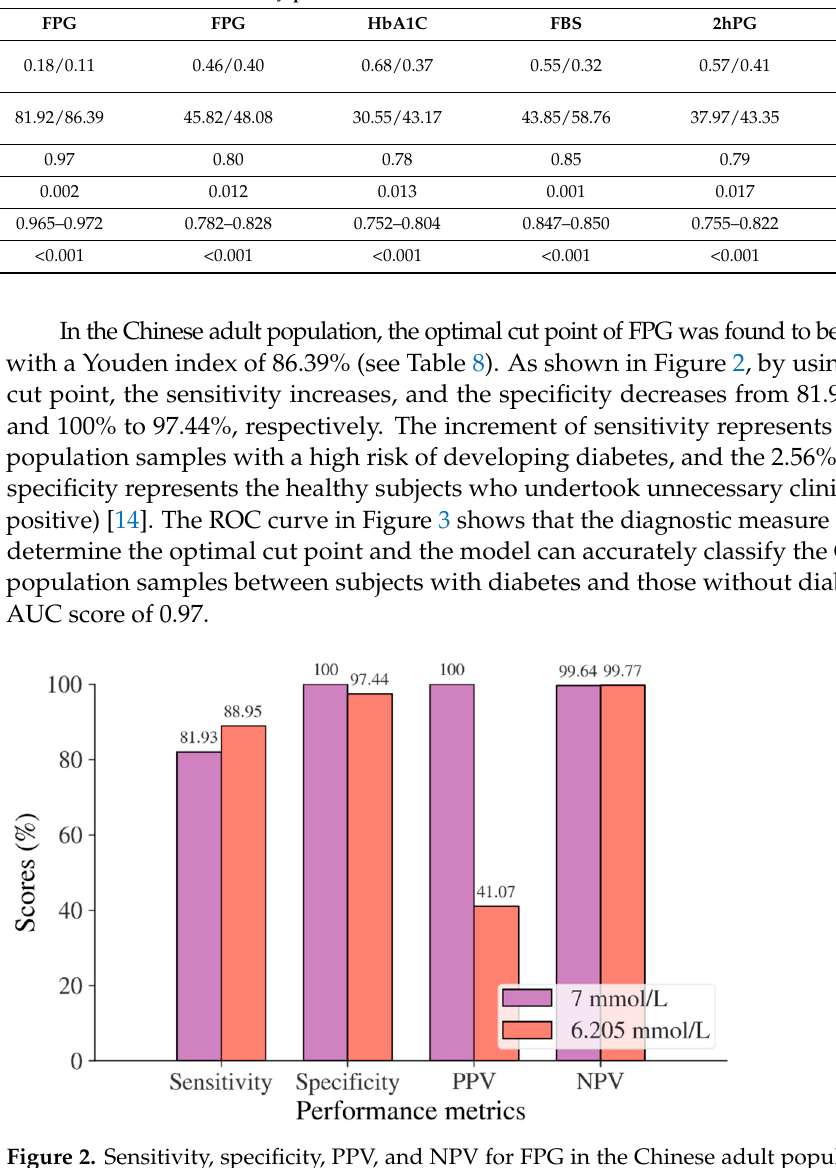
Figure 2. Sensitivity, specificity, PPV, and NPV for FPG in the Chinese adult population based on ADA and WHO cut point recommendations compared to the optimal cut point.